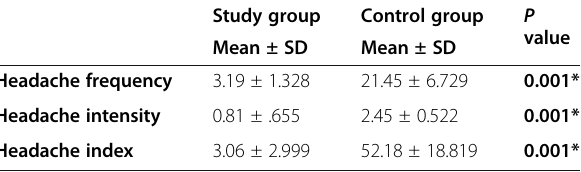
Table 5 Comparison of post treatment headache parameters between the study and control groups Study